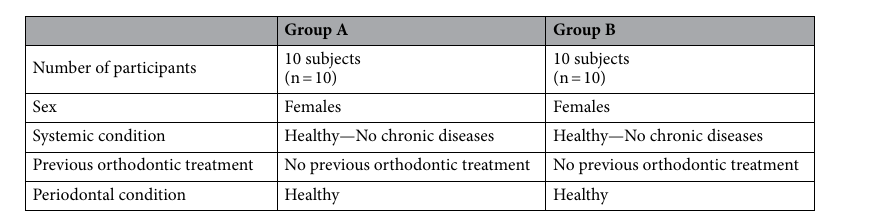
Table 2. Demographic data regarding the enrolled study subjects in both groups A and